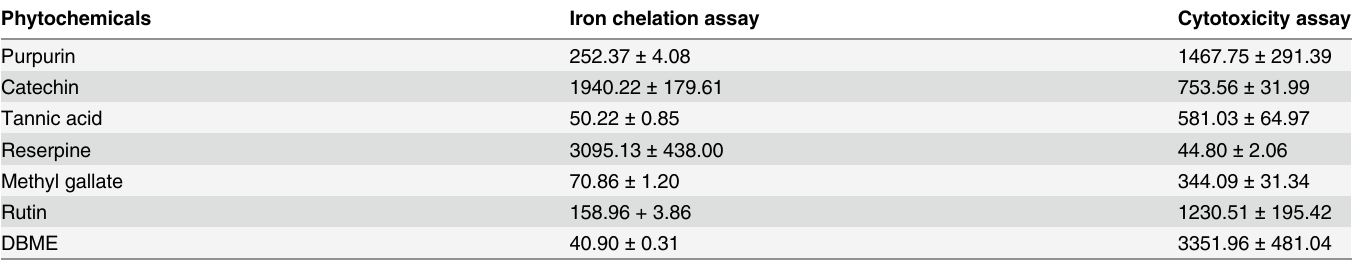
Table 5. IC 50 values of purpurin, catechin, tannic acid, reserpine, methyl gallate, rutin and DBME for in vitro iron chelation and cytotoxicity against WI-38